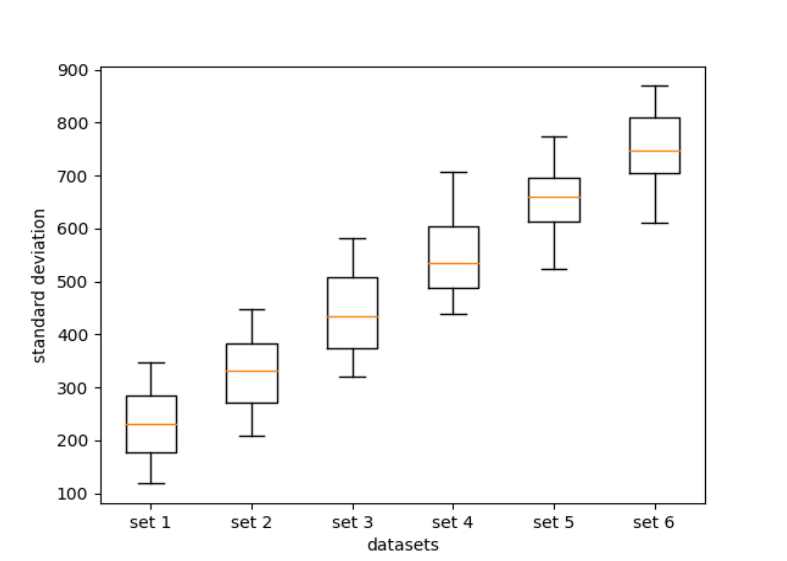
Figure 7. For each test set used for scalability analysis (set 1 to set 6): the box-plots of the standard deviation of the targets in each of the 20 input data (50 targets to 1000